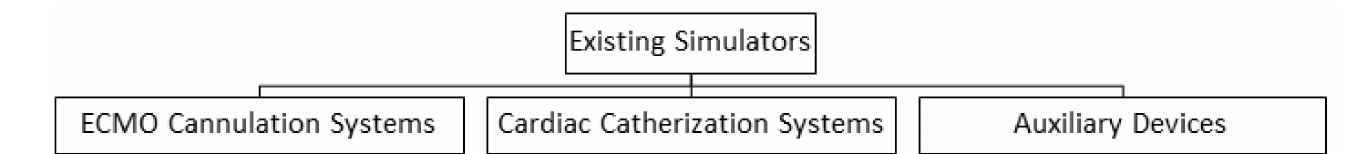
Figure 2. Femoral region ultrasound scan [7].